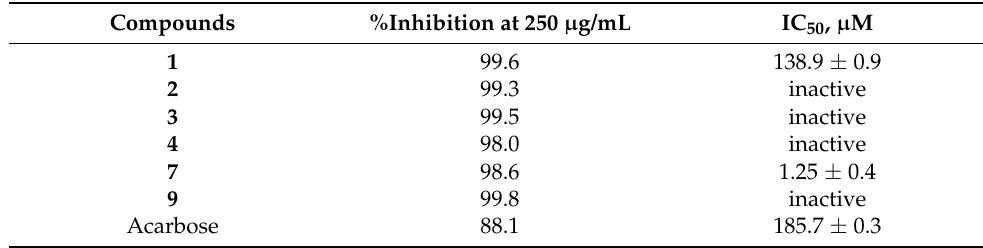
Table 3. α -Glucosidase inhibitory activity of some isolated compounds from G. ridleyi